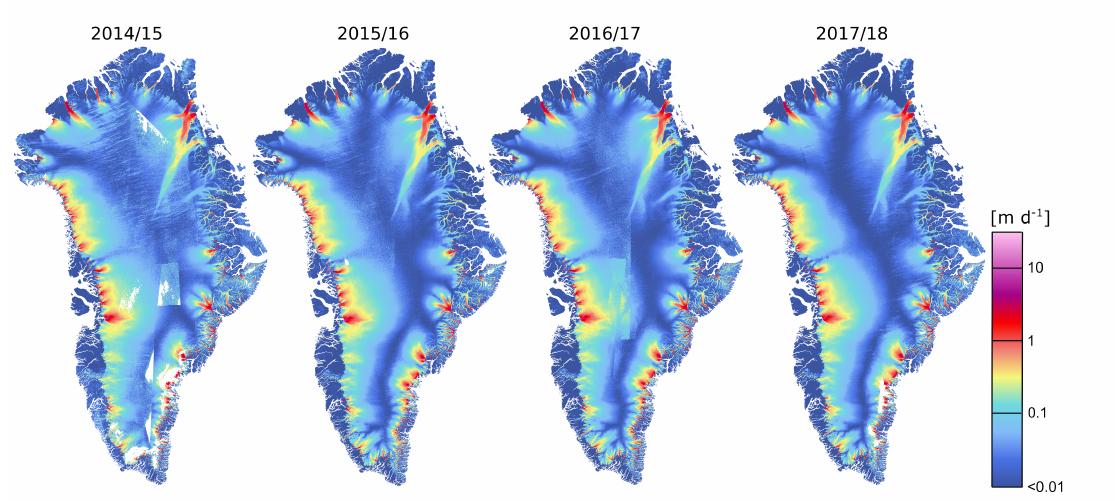
Figure 1. Greenland ice sheet climate change initiative (CCI) annual ice velocity maps derived from Sentinel-1 SAR data 2014–2017 and winter campaign map